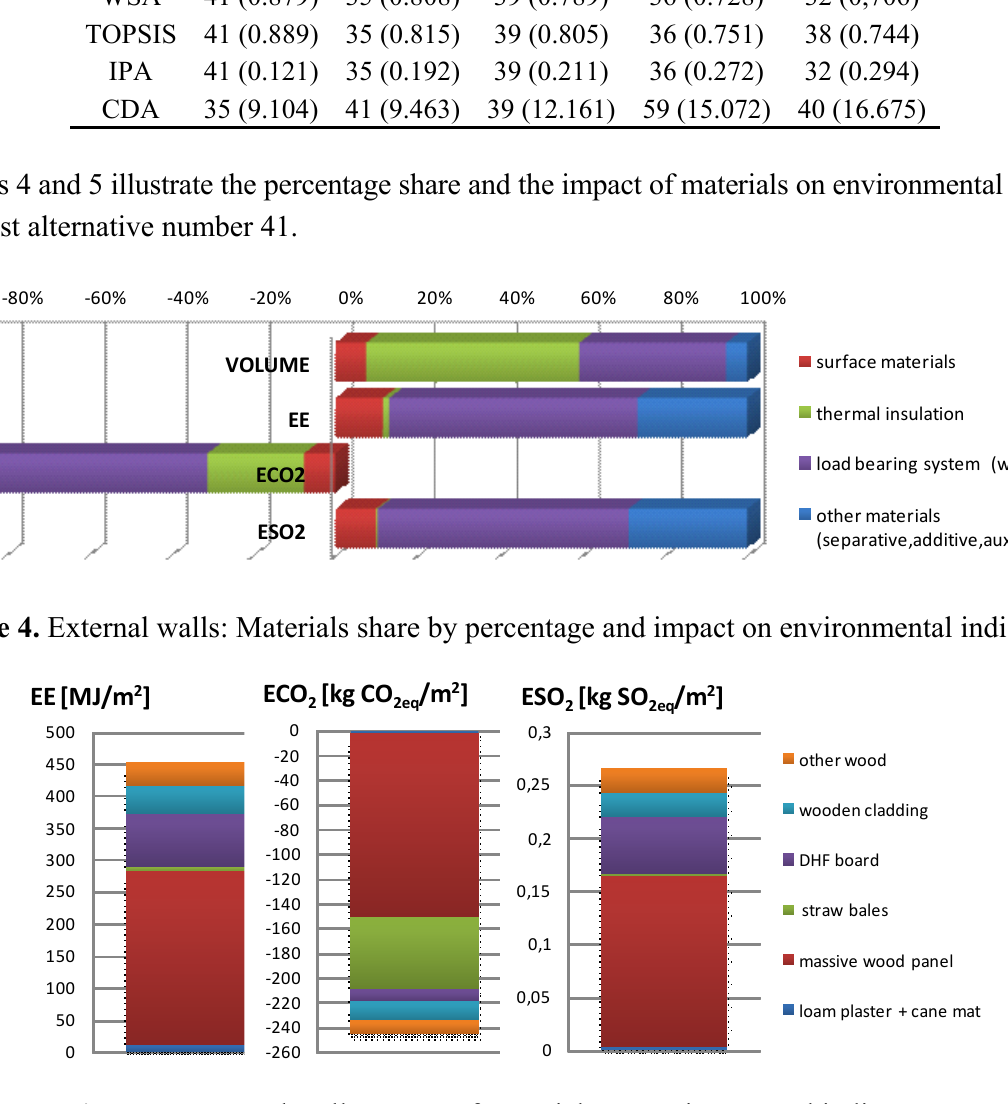
Figure 5. External wall: Impact of materials on environmental